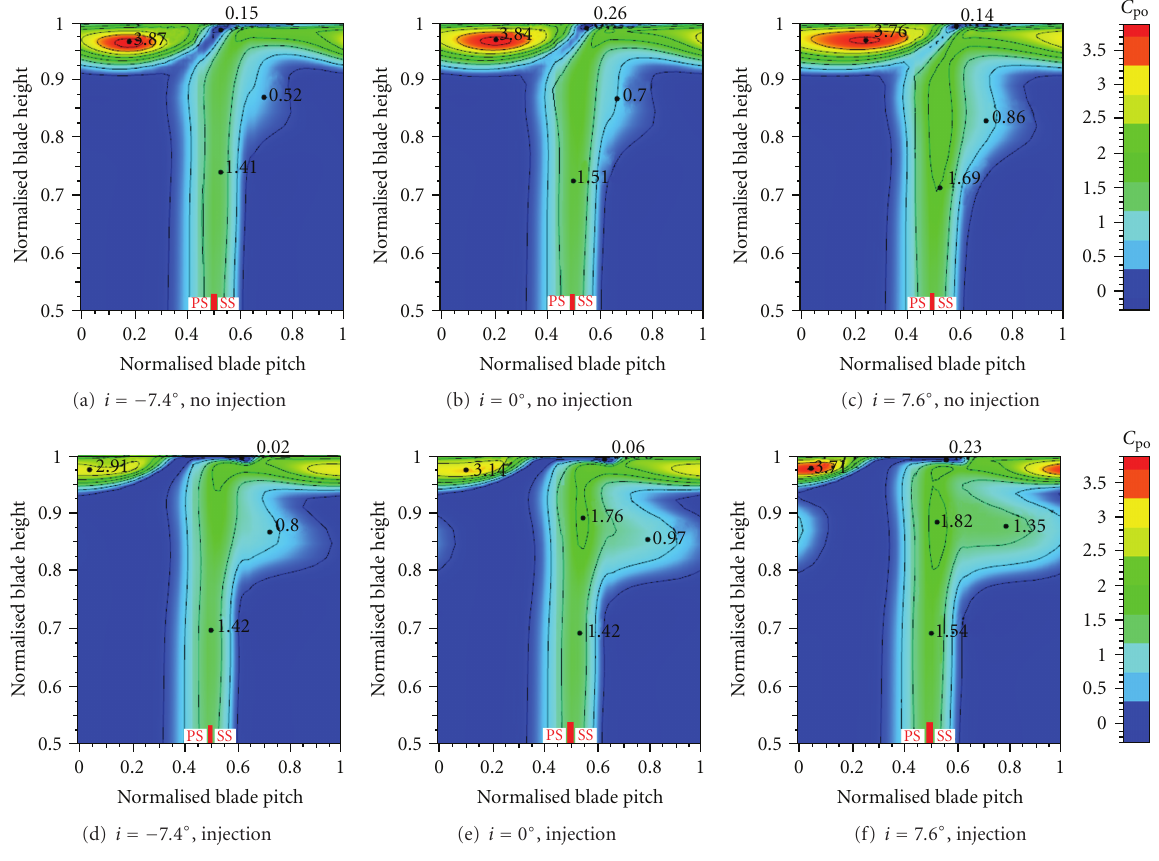
Figure 5: Distribution of total pressure loss coe ffi cient at cascade exit.